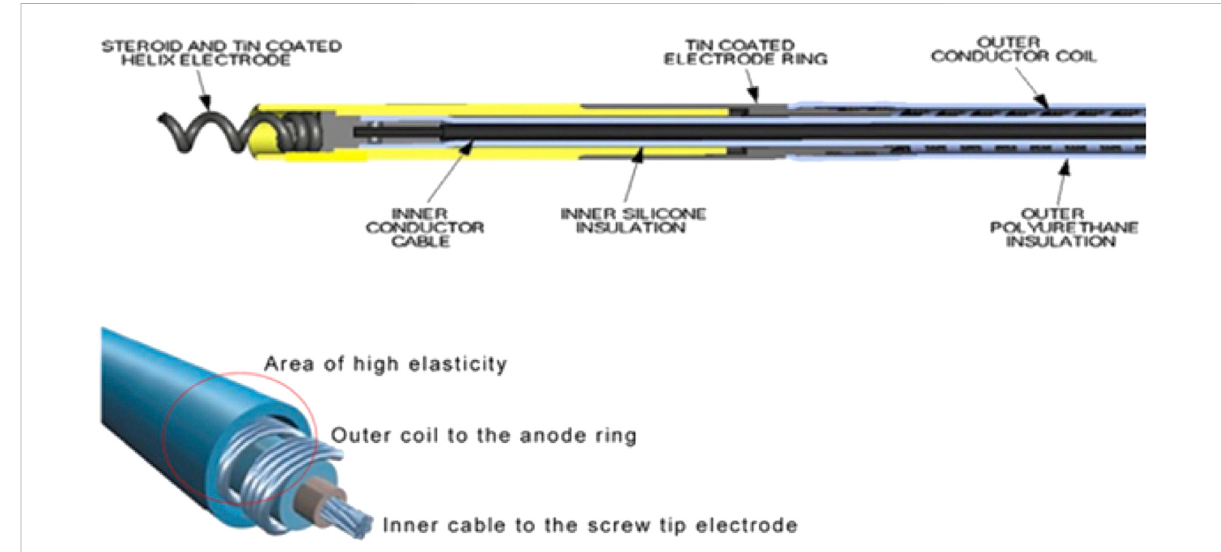
FIGURE 2 Design of the Medtronic 3,830 Lead. Reproduced from reference 31, Krainski et al., with